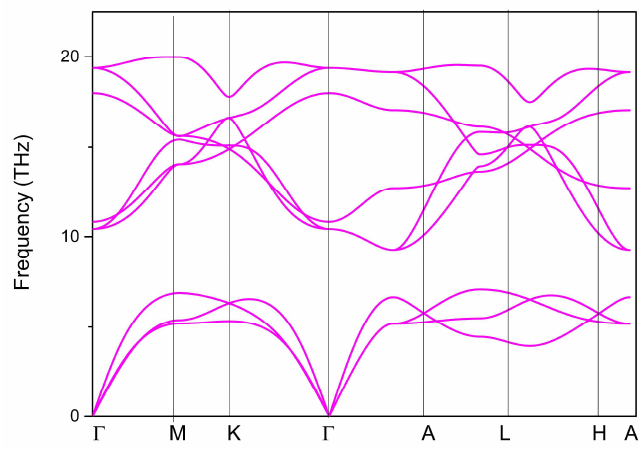
Figure 2. Phonon dispersion curve of YB 2 .